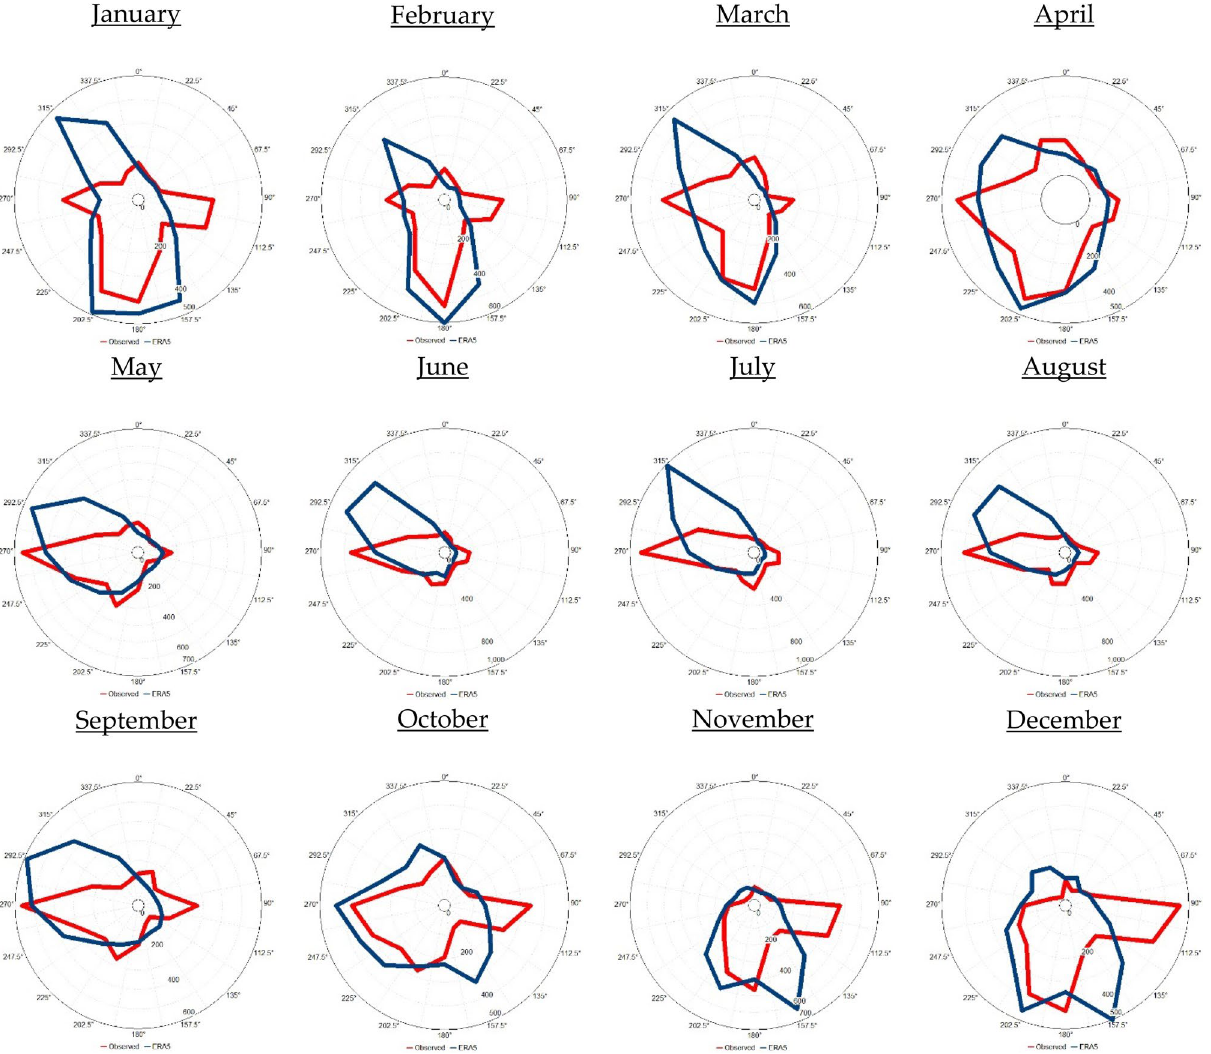
Figure 8. Observed (ERA5) monthly wind rose diagram based on the hourly observed (ERA5) data from 2016 to 2020 in Jizan. The blue colour indicates the observations, while the red colour indicates the ERA5 data.